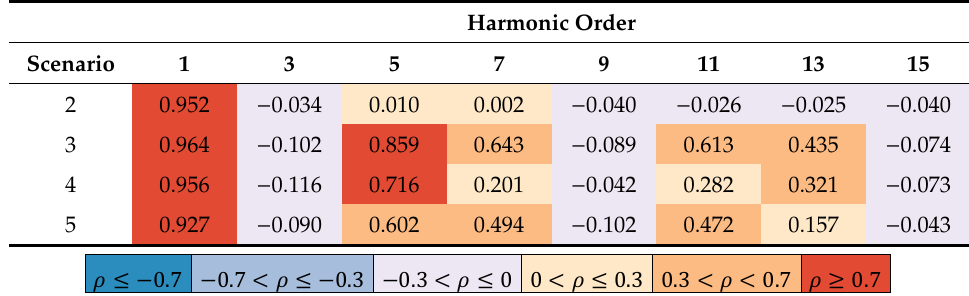
Table 7. Pearson correlation coefficient between CUF and the magnitude of the neutral harmonic currents.